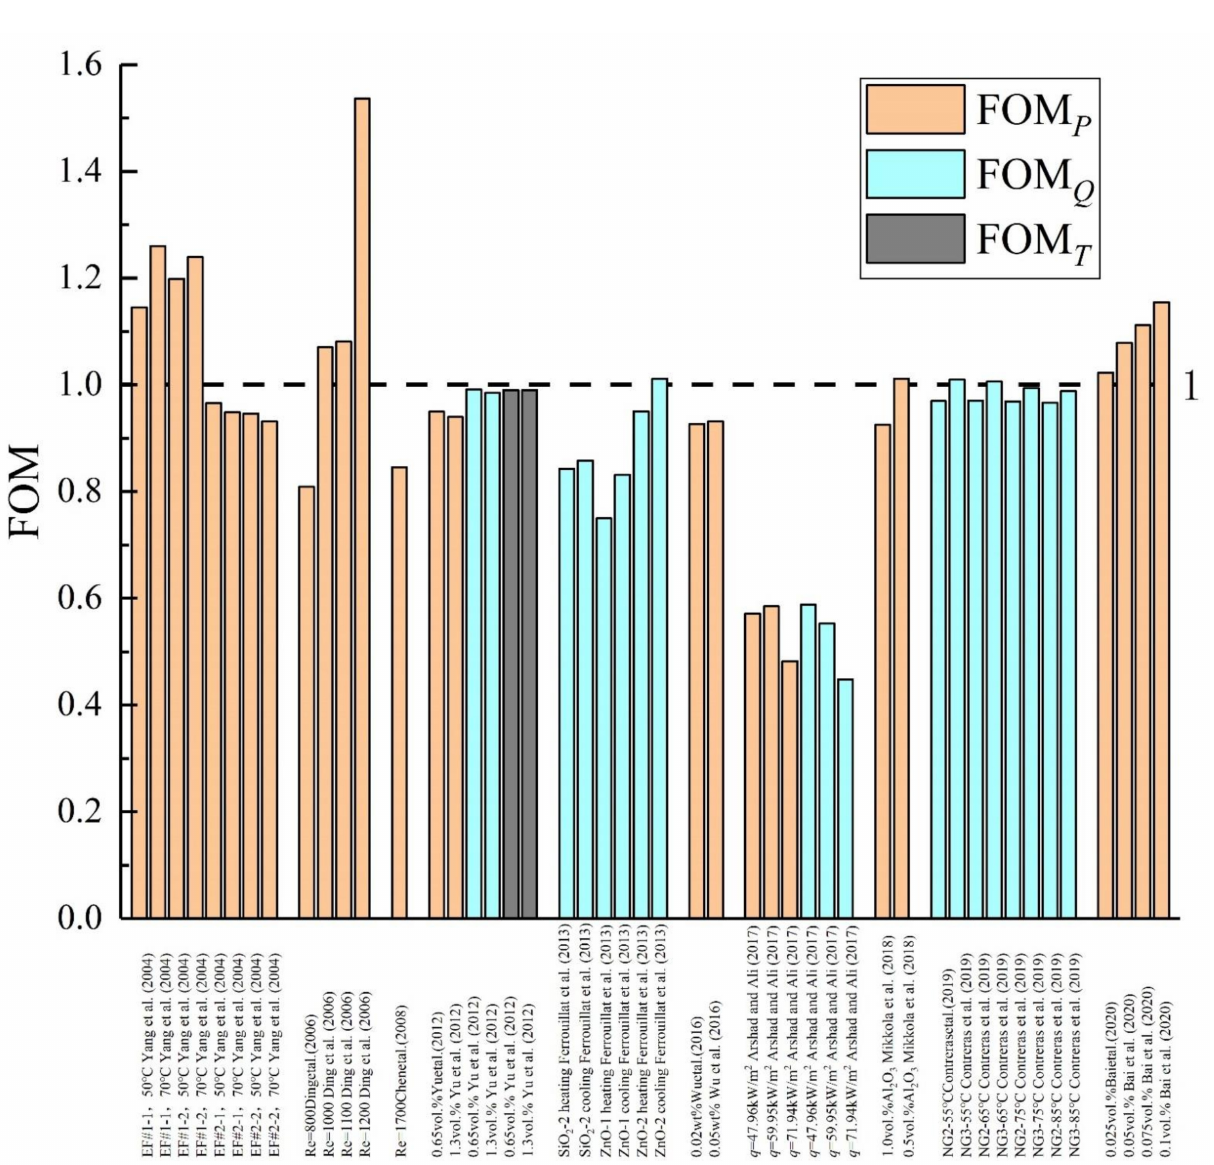
Figure 5. Thermohydraulic performance evaluation in the literature